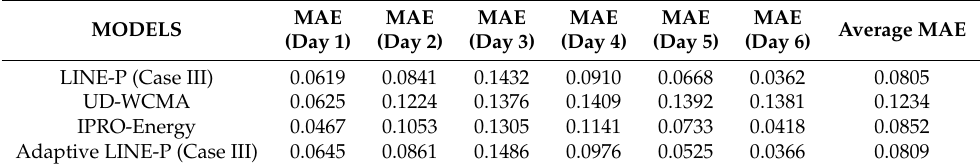
Table 10. Error comparison of the prediction models based on MAE for the SDG&E solar energy profile. MODELS